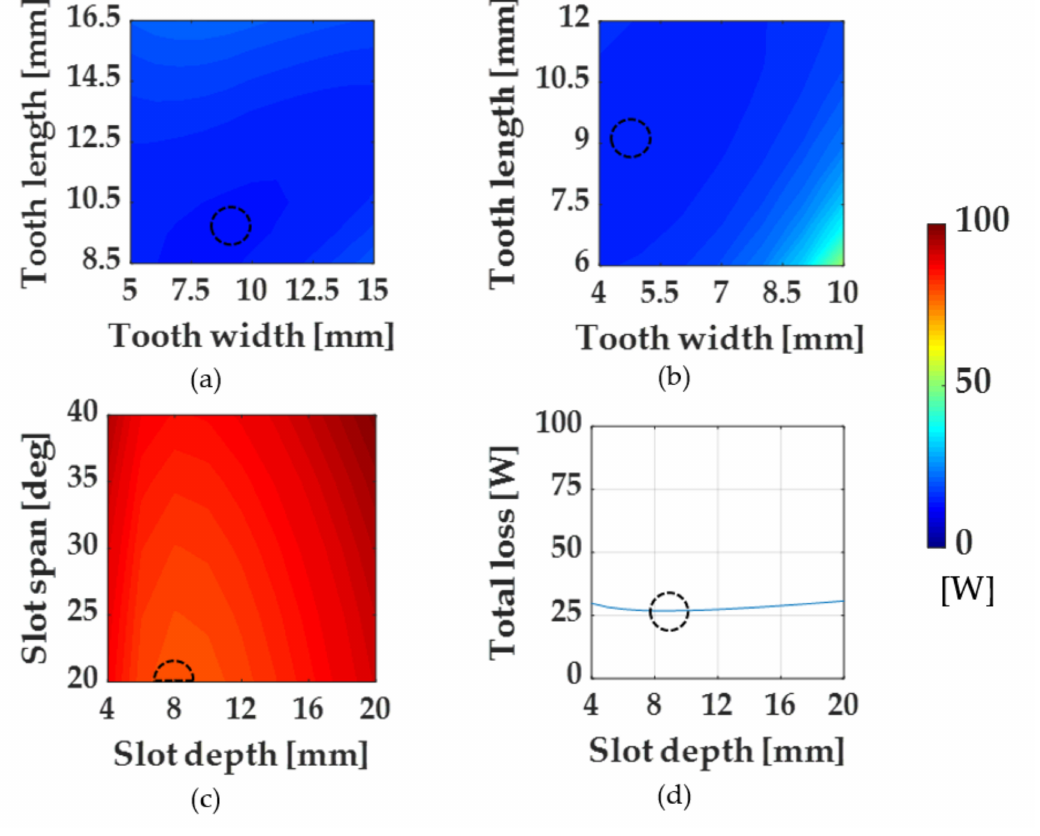
Figure 8. Stator geometric design for the total loss minimization: ( a ) 3Slot-1CS, ( b ) 6Slot-3CS, ( c ) 3Sless-1CS, and ( d ) 6Sless-3CS (no sleeve, 1 p.u. torque and rated speed 80